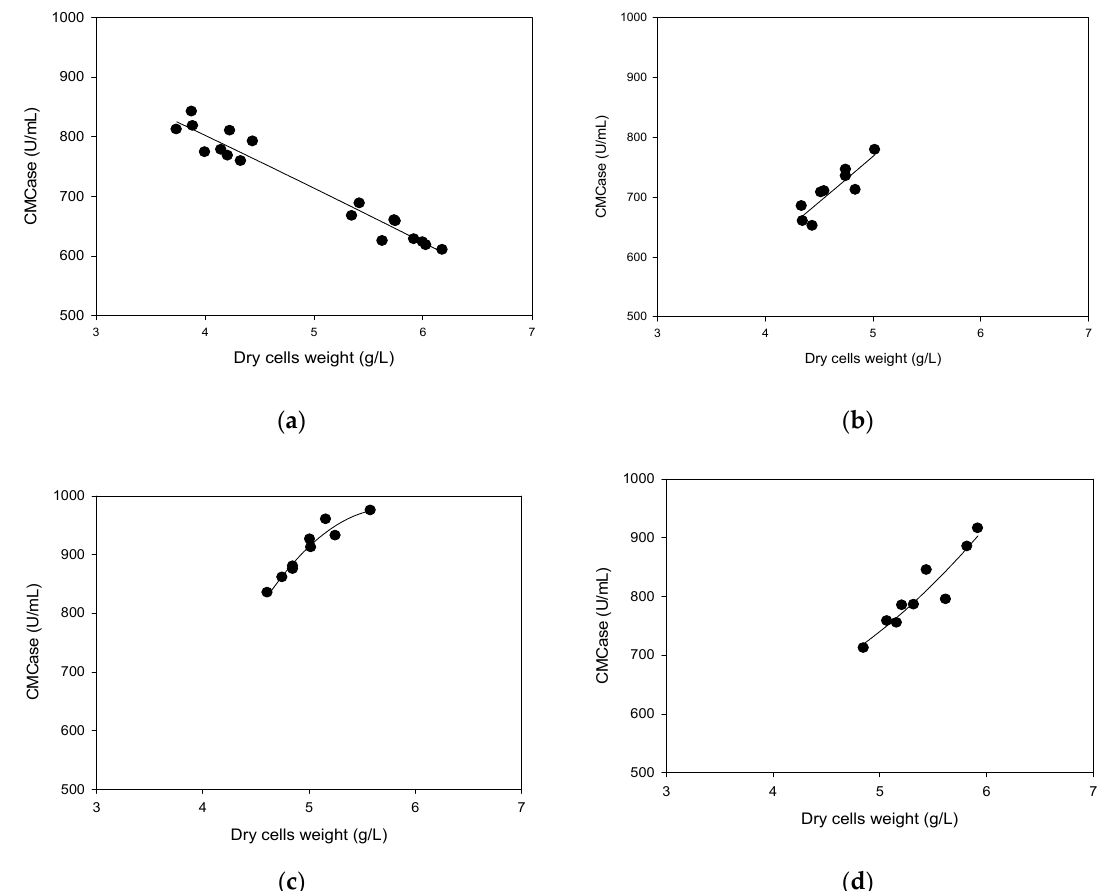
Figure 4. Relationship between cell growth and production of CMCase by E. coli KACC 91335P ( a ) without shifts in agitation and/or aeration, ( b ) with shifts in agitation and/or aeration at 24 h, ( c ) with shifts in agitation and/or aeration at 26 h and ( d ) with shifts in agitation and/or aeration at 48 h.